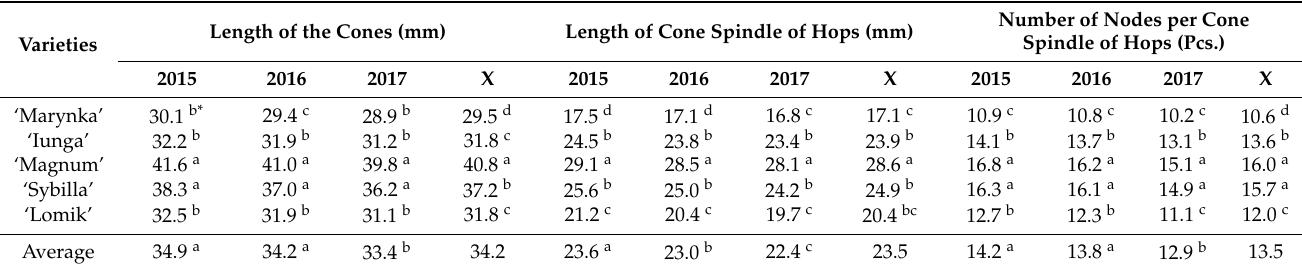
Table 11. The length of the cones and the length of cone spindle as well as the number of nodes per cone spindle of hops depending on the variety and years (Mean for location).